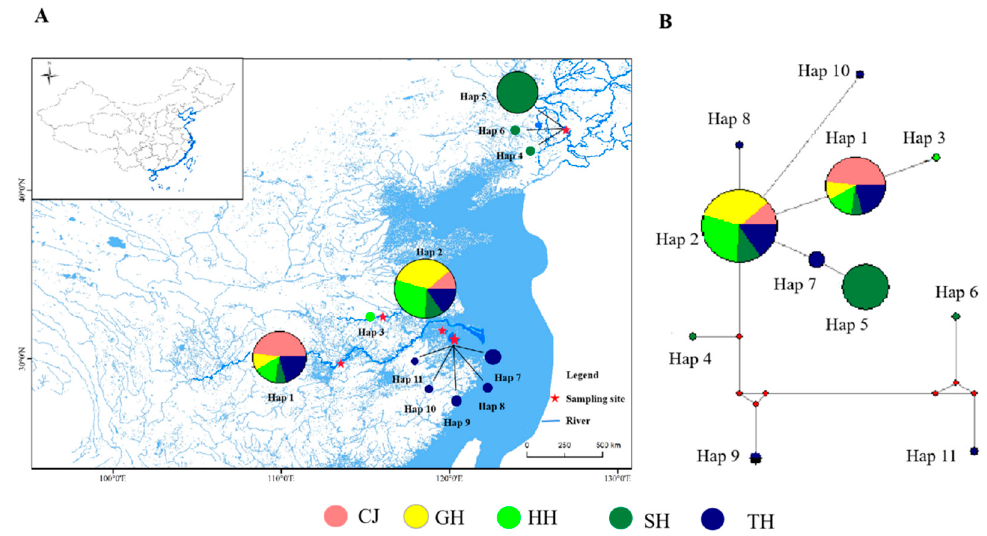
Figure 3. Geographical distribution of haplotypes ( A ) and haplotype network tree ( B ).